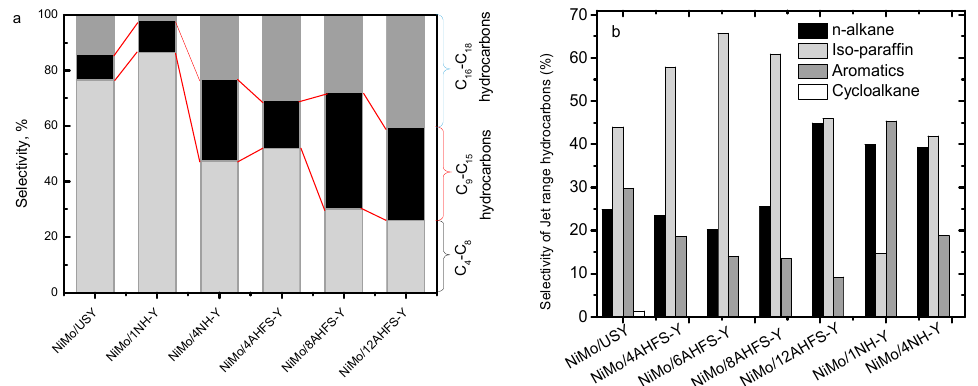
Figure 6. ( a ) The products distribution and ( b ) selectivity of various jet range hydrocarbon in the conversion of WCO over different catalysts.